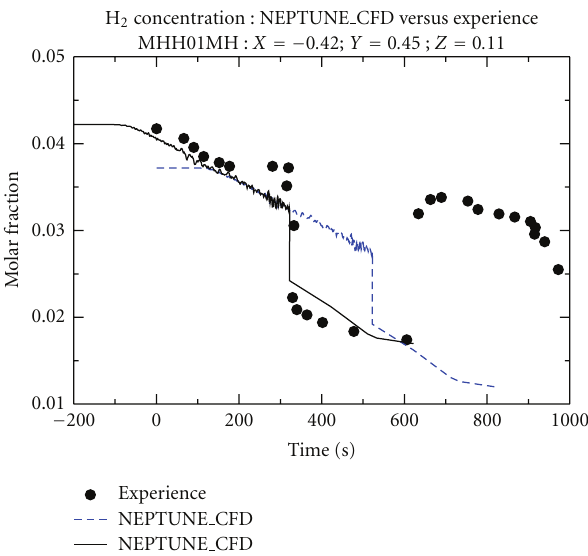
Figure 14: H 2 molar fraction just below the PAR.